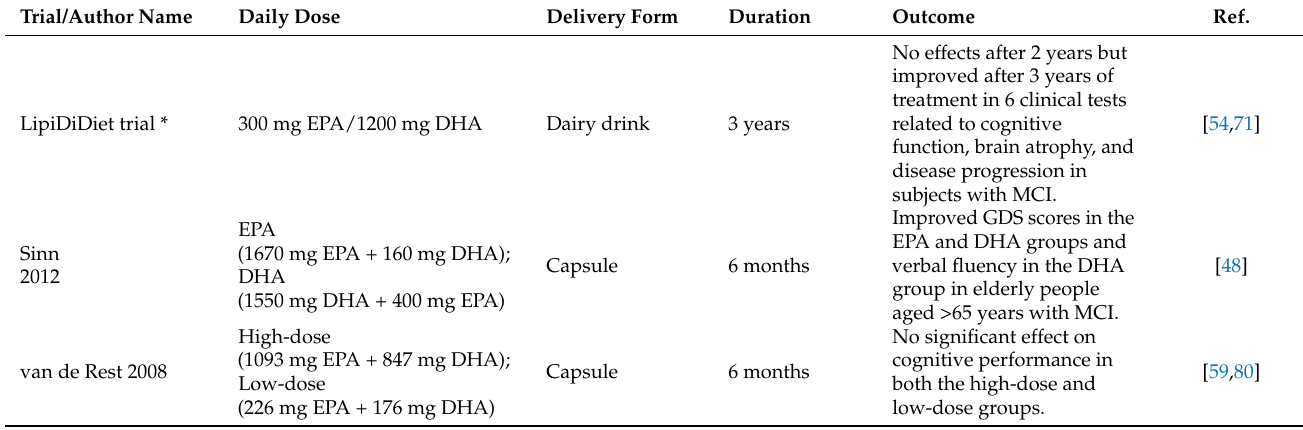
Table 1. Summary of clinical trials for the effects of n-3 PUFA on neural development and neurode- generative